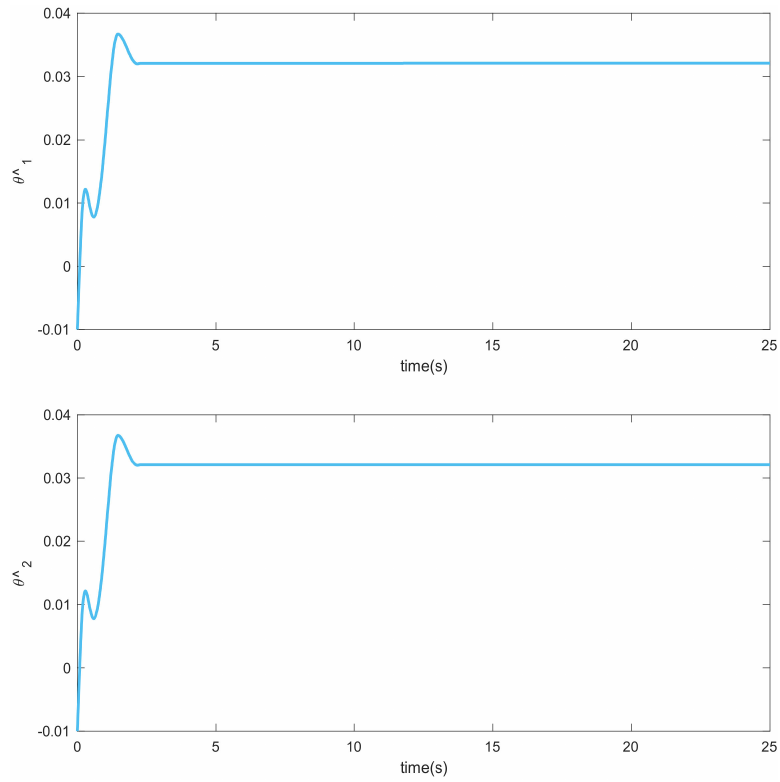
Figure 13. Adaptation laws based on neural network. (Example